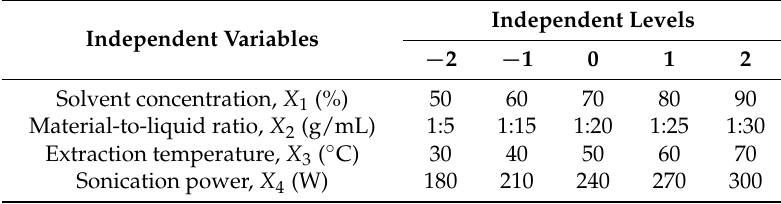
Table 4. Independent variables and their levels and corresponding coded values used in